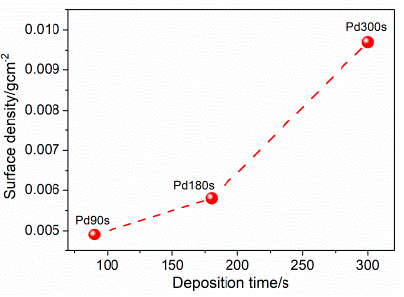
Figure 5. Relationship between the surface density of Pd samples and the deposition times. The dashed line is used as a guide for the eyes.